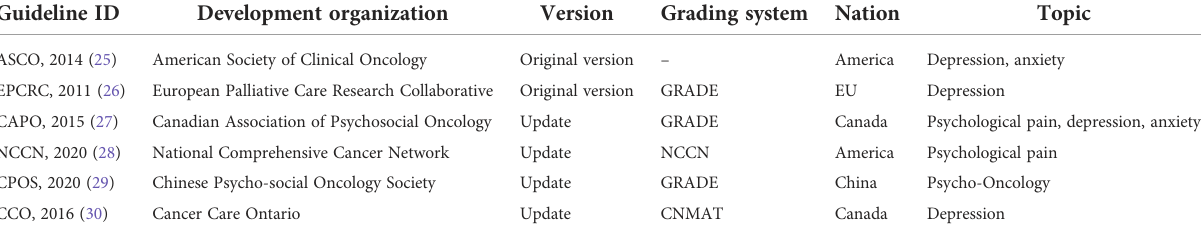
TABLE 1 Characteristics of included guidelines.